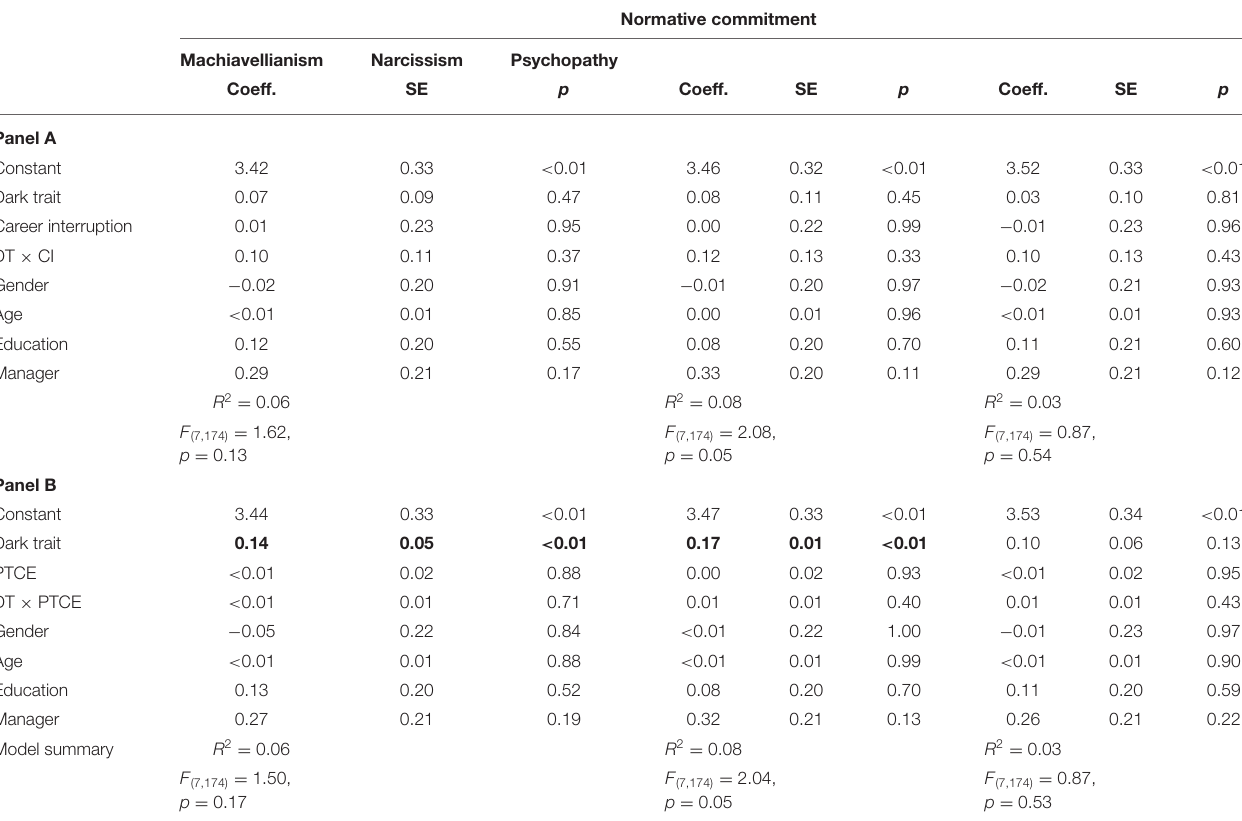
Normative commitment